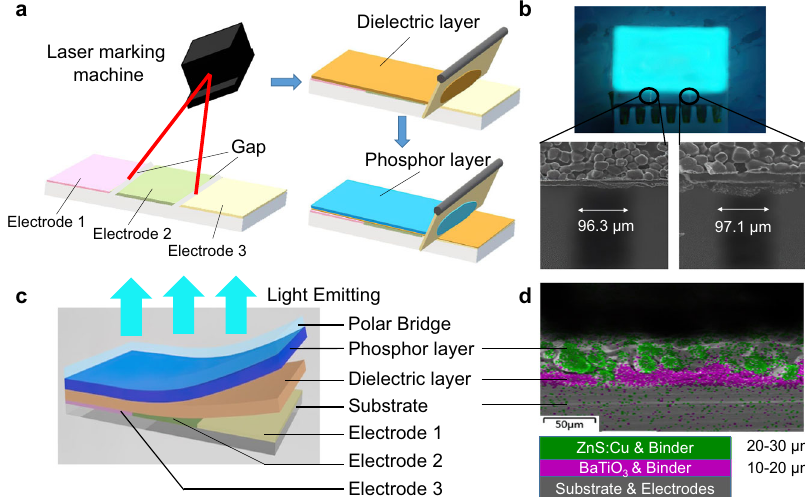
Fig. 1 Schematic illustration of the preparation process and characterization of TPEL devices. a Fabrication process of a standard TPEL device, including three electrodes preparation with gaps formation between them by laser marking and blade coating the dielectric and phosphor layers. b The photograph of working TPEL device (3 × 2 cm) operated with DI water polar bridge. Bottom fi gures show SEM images of the inter-electrode gaps. c Schematic “ exploded view ” of a TPEL device with three separated coplanar electrodes, a dielectric layer and a light-emitting layer blade coated above the electrodes. A polar bridge is not an inherent part of the TPEL device but necessary for light emission. d Cross-sectional energy dispersive X-ray spectroscopy (EDS) map of a TPEL device, with its schematic representation on the bottom. The colors on the EDS image correspond to that on the bottom scheme. The green and purple parts on the map represent the elements Ba and Zn, respectively, whereas the gray color in a phosphor layer and dielectric layer is a